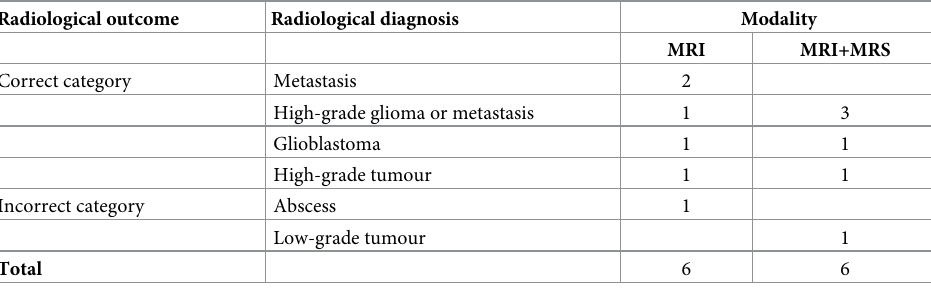
Table 7. Distribution of radiological diagnoses in cases with a confirmed metastatic disease.